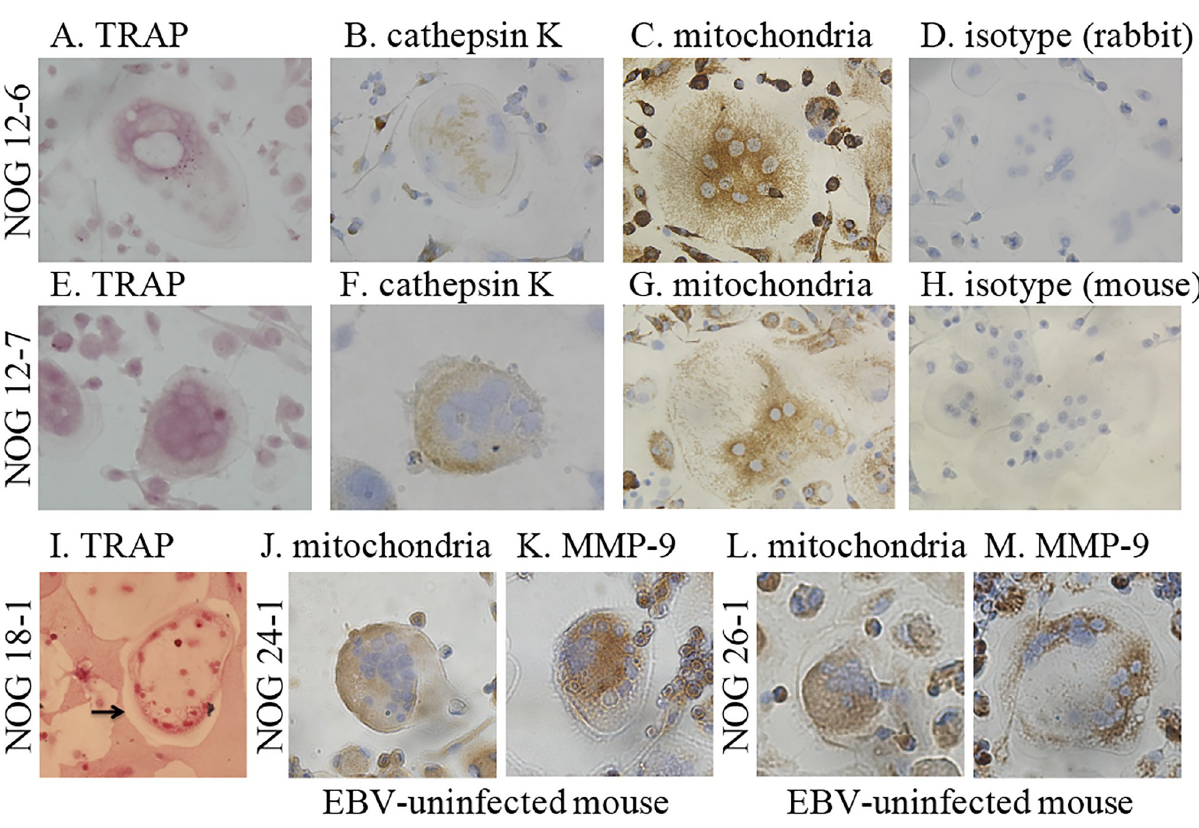
Fig 4. Cytochemistry of cultured long bone marrow cells from EBV-infected and -uninfected hu-NOG mice in the presence of M-CSF and RANKL differentiation signals. (A–D) Cultured cells from an EBV-infected mouse (NOG 12–6). (A) Cultured cells stained for TRAP. TRAP in the cultured multinucleated cell stained red violet. (B) Cultured cells immunostained for human cathepsin K. The positive multinucleated cell stained brown with the anti-human cathepsin K antibody (dilution, 1:1800). (C) Cultured cells immunostained for human mitochondrial protein. Multinucleated cell positively stained brown with anti-human mitochondria antibody (dilution, 1:40). (D) Cultured cells immunostained using isotype control rabbit immunoglobulin (dilution, 1:4500). (E–H) Cultured cells from another EBV-infected mouse (NOG 12–7). The multinucleated cells positively stained for TRAP (E), and with anti-human cathepsin K antibody (dilution, 1:600) (F) and anti-human mitochondria antibody (dilution, 1:10) (G). (H) Cultured cells immunostained using isotype control mouse immunoglobulin (dilution, 1:5). (I) Cultured cells from another EBV-infected mouse (NOG 18–1) on a pit formation assay plate. TRAP in the cultured multinucleated cells stained red violet. Calcium phosphate coating around the TRAP-positive multinucleated cell was eliminated (arrow). (J and K) Cultured cells from an EBV-uninfected mouse (NOG 24–1). (J) Cultured cells immunostained for human MMP-9. The multinucleated cell positive for human MMP-9 stained brown with anti-human MMP-9 antibody (dilution, 1:25). (K) Cultured cells immunostained for human mitochondrial protein. The multinucleated cell positive for human mitochondrial protein stained brown with anti- human mitochondria antibody (dilution, 1:10). (L and M) Cultured cells from another EBV-uninfected mouse (NOG 26–1). The multinucleated cells were considered positive when stained with anti-human MMP-9 antibody (dilution, 1:50) (L) and anti-human mitochondria antibody (dilution, 1:40) (M). (original magnification, 400 × ) Republished from [Nagasawa Y, Ikumi N, Nozaki T, Inomata H, Imadome K, et al. Human osteoclasts are mobilized in erosive arthritis of Epstein-Barr virus-infected humanized NOD/Shi-scid/IL2R γ null mice. 2014 ACR/ARHP Annual Meeting. Abstract number:2340.] under a CC BY license, with permission from [American College of Rheumatology], original copyright